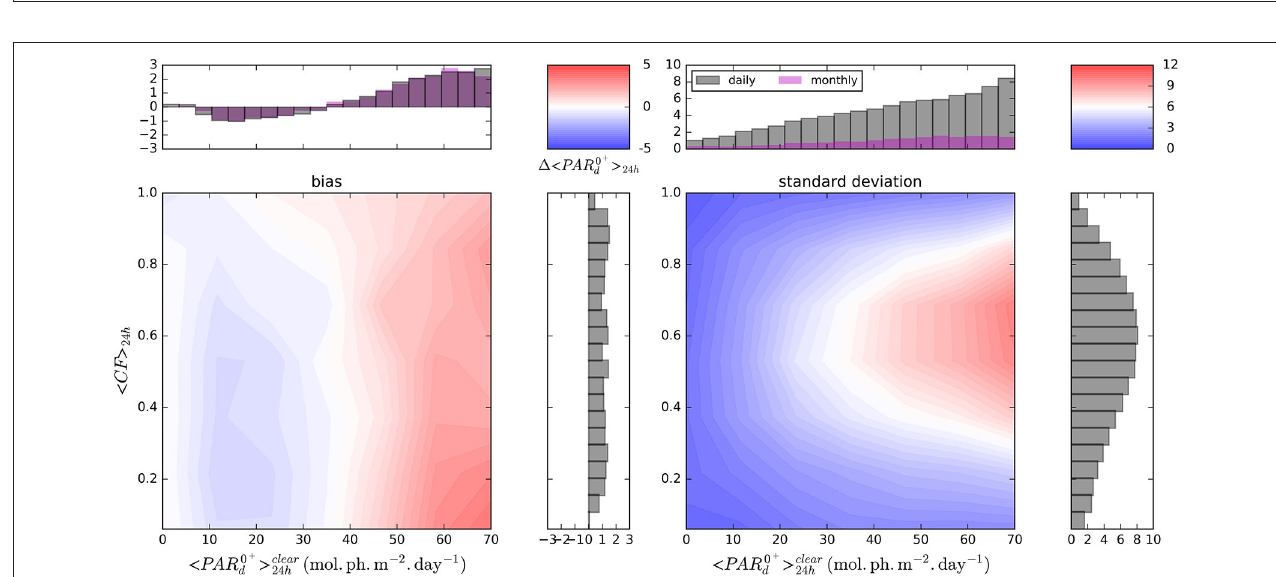
FIGURE 17 | Same as Figure 15 but for the ratio of spectral scalar PAR below the surface at 405 and 675nm.